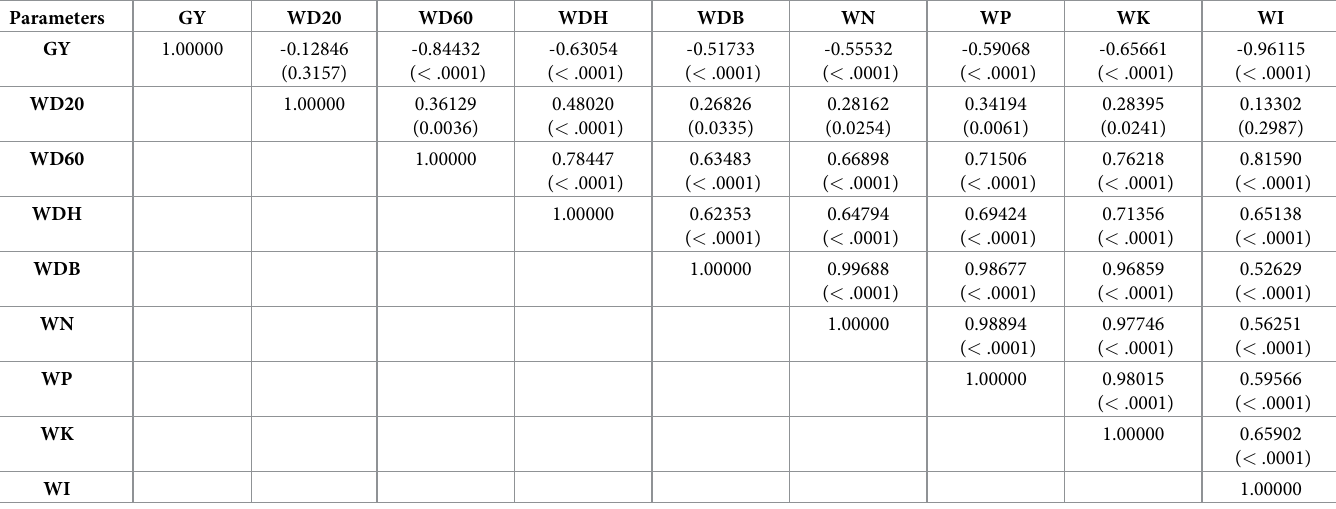
Table 8. Pearson’s correlation coefficients (N = 63) between yield and weed